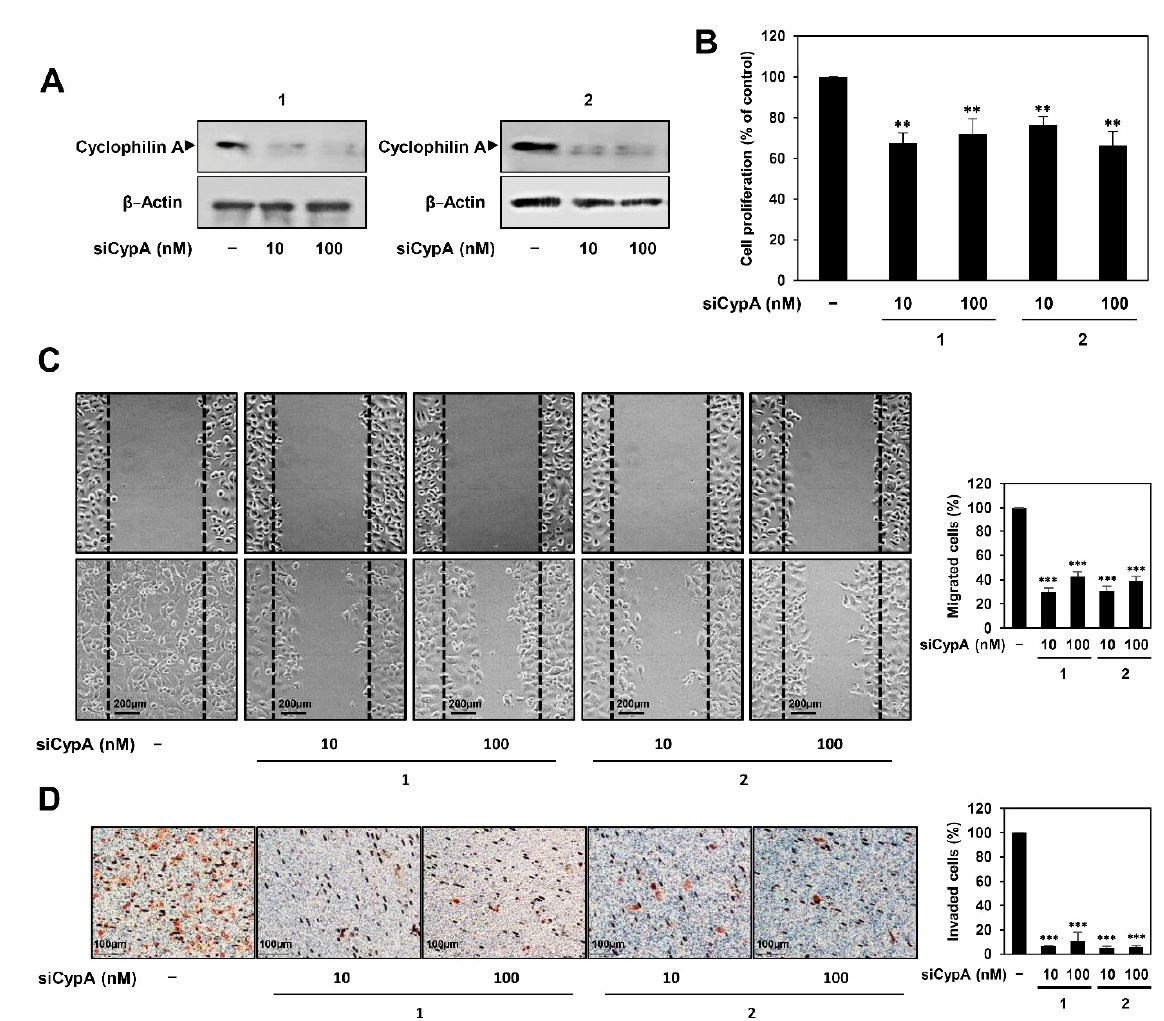
Figure 4. Effect of CypA knockdown on the proliferation, migration, and invasion of AGS cells. AGS cells were transfected with two types of CypA siRNAs (10 and 100 nM). ( A ) Knockdown of CypA gene was confirmed by western blot analysis. ( B – D ) Effect of CypA knockdown on the ( B ) proliferation, ( C ) migration, and ( D ) invasion of AGS cells. ** p < 0.01, *** p < 0.001 vs. the control.